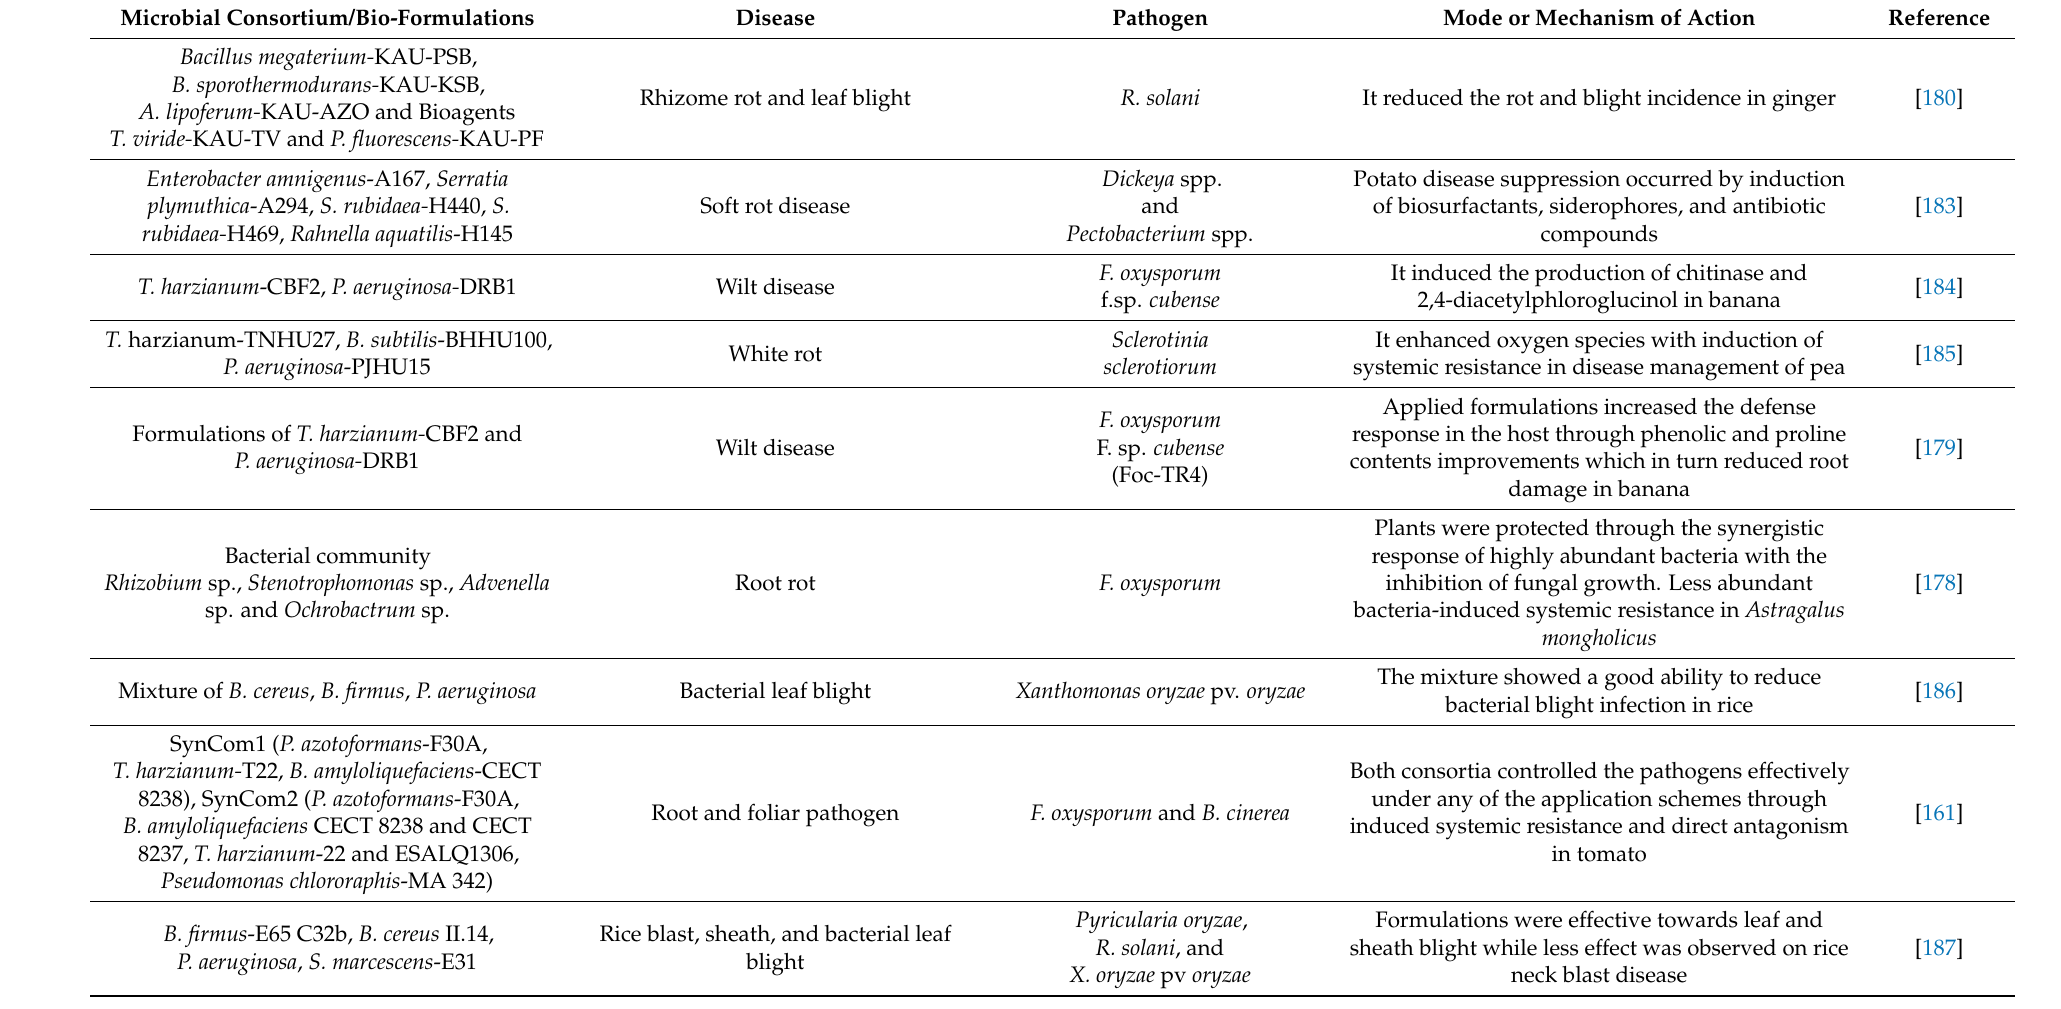
Table 2. Effects of synthetic consortium/bio-formulations in plant disease